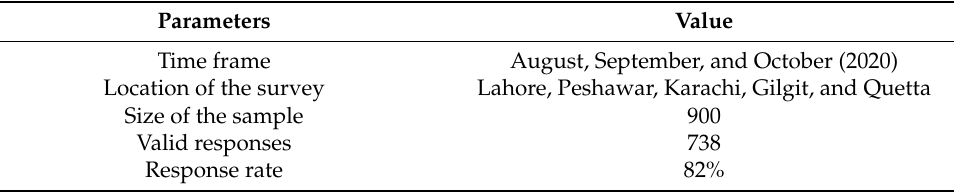
Table 1. Description of